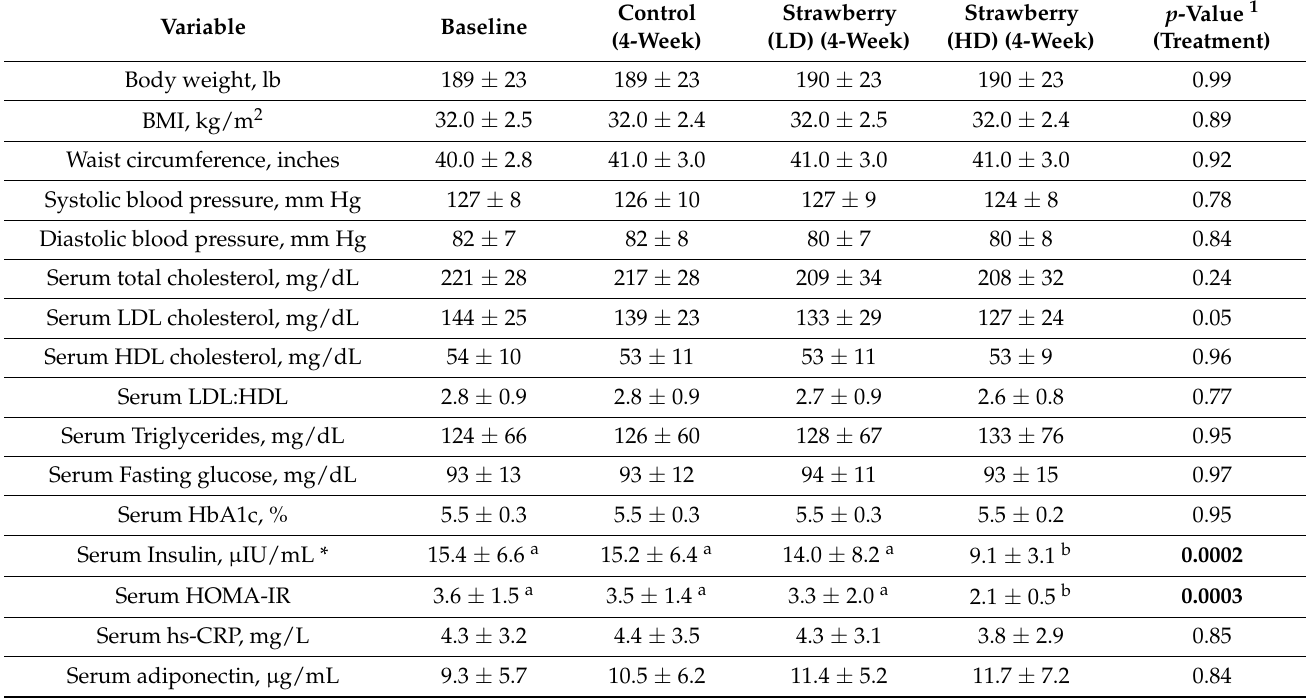
Table 3. Cardio–metabolic profiles in obese adults with above optimal serum LDL cholesterol following each treatment period in a randomized crossover